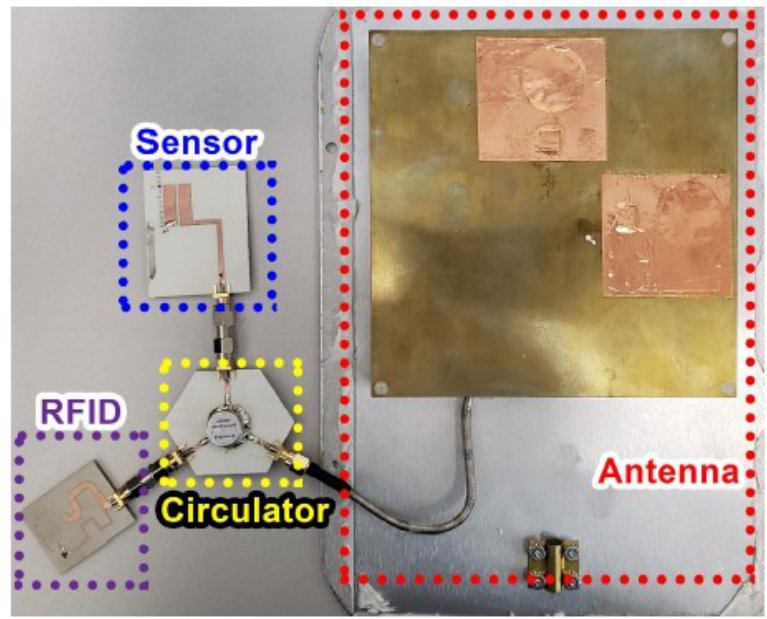
Figure 23. Implemented circuit of the flood sensor